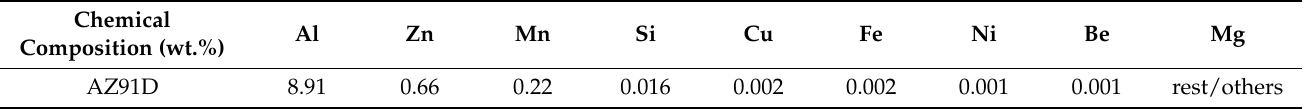
Table 1. The chemical composition of the AZ91D magnesium alloy.